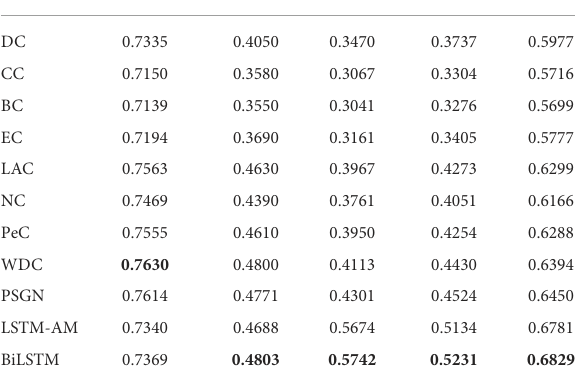
TABLE 3 Comparison of performance between our proposed non-local GNN and other classical methods.